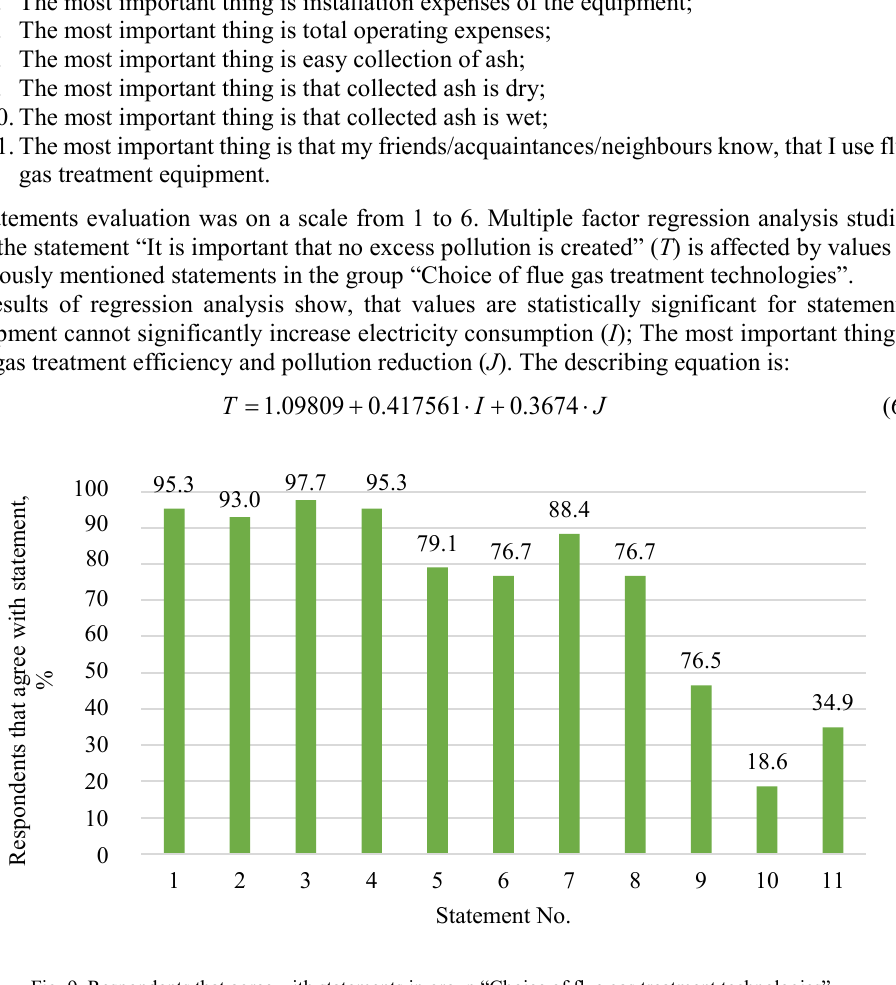
Fig. 9. Respondents that agree with statements in group “Choice of flue gas treatment